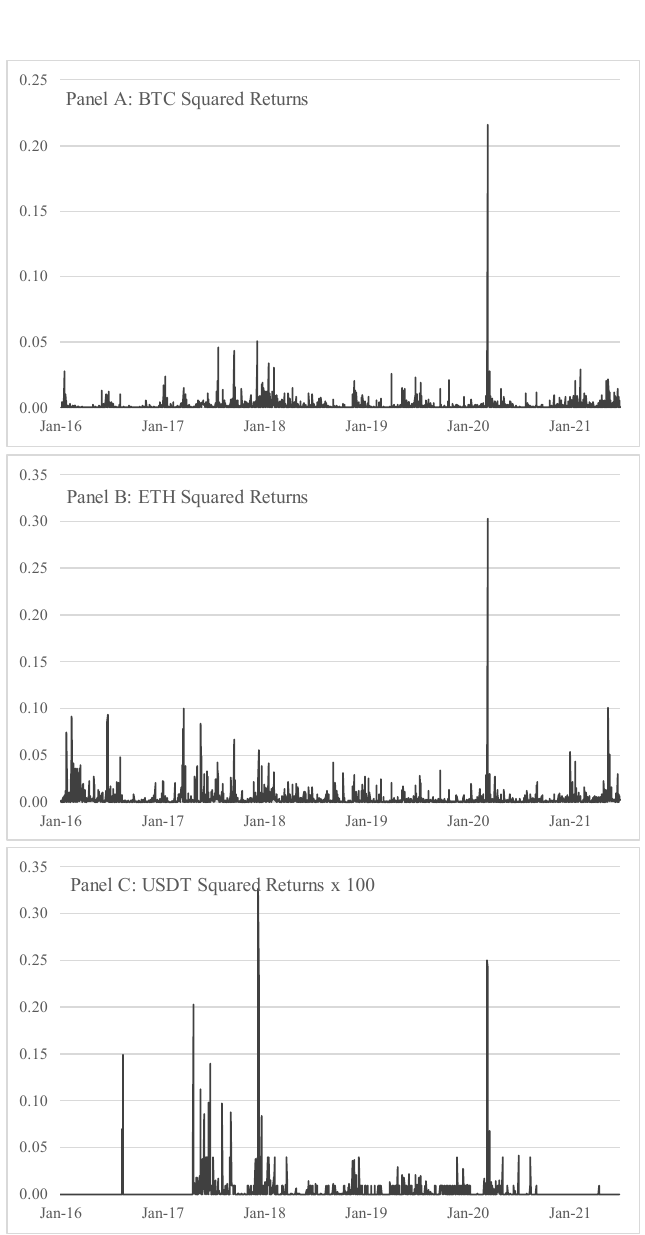
Figure 3. Cryptocurrency squared returns.